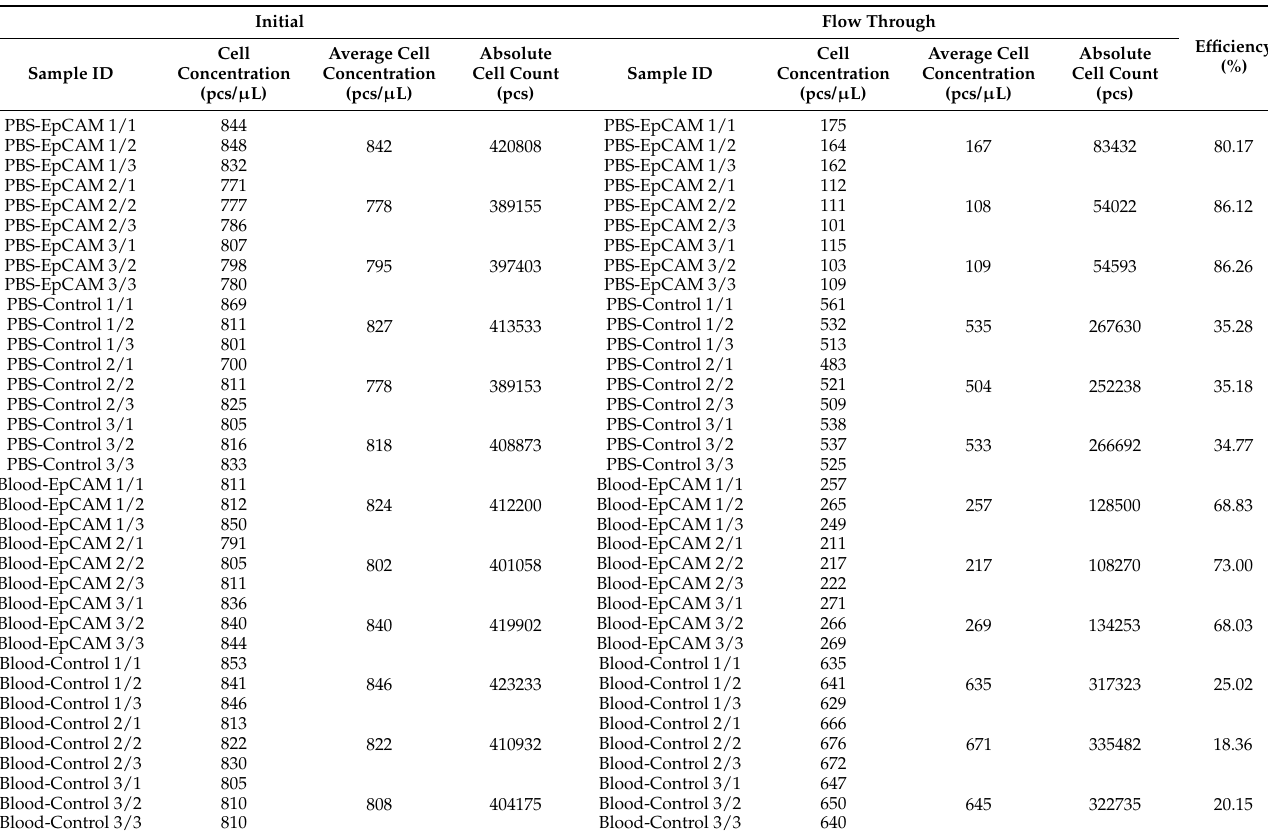
Table 1. Results of the flow cytometry analysis and the calculated capture efficiencies. HCT116 cells were spiked into PBS buffer and whole blood, followed by cell capture experiments utilizing the cell capture technology introduced in this paper. Samples were measured in triplicates. Numbering of the sample ID indicates the corresponding repetitions. The reported cell concentration values were directly measured by flow cytometry utilizing fluorescent microspheres as the internal standard. Absolute cell counts are calculated